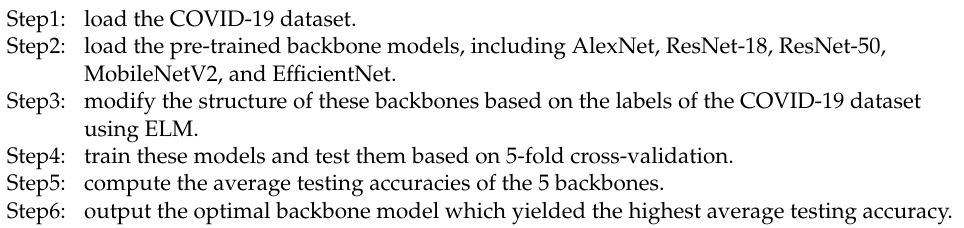
Table 1. Pseudocode of the optimal backbone model selection